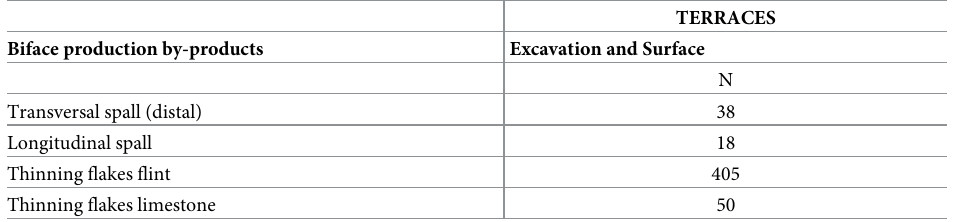
Table 12. Different debitage categories resulting from production of bifaces.